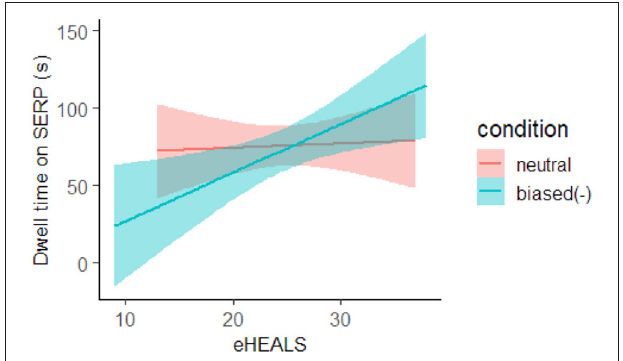
FIGURE 5 | Estimated effect of condition and eHEALS on maximum click depth. The red line represents the NEUTRAL group, and the blue line represents the BIASED( − ) group. The background color indicates the confidence